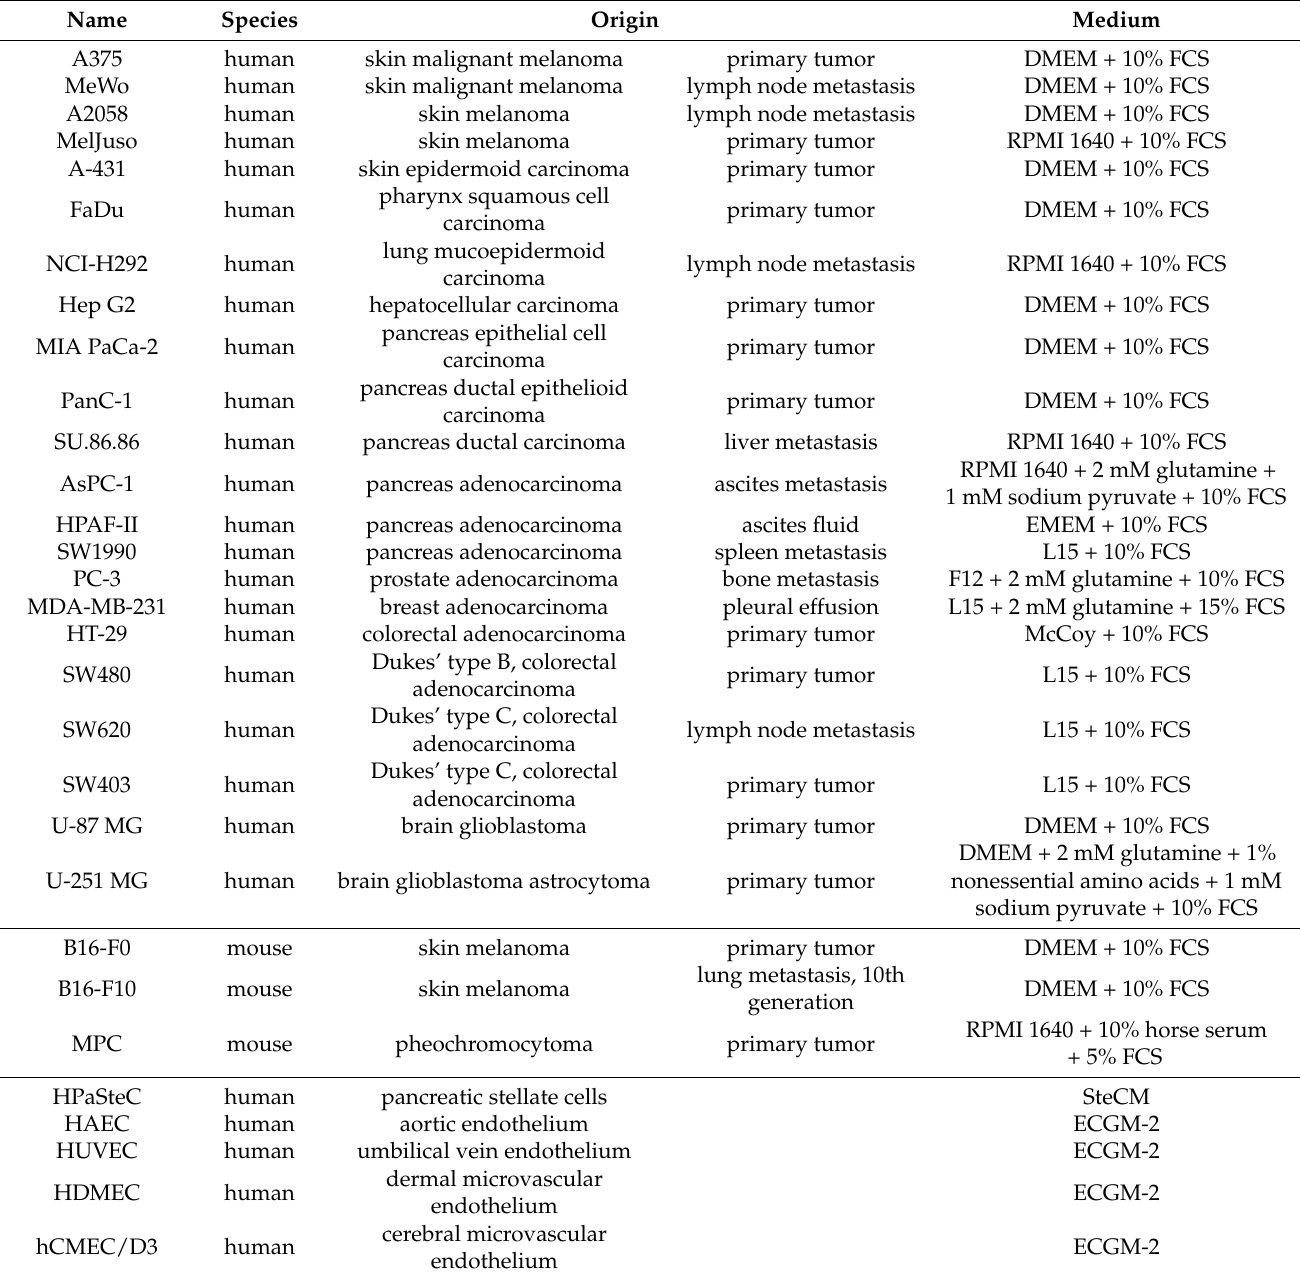
Table 5. Investigated cell lines and appropriate cell culture media (information on origin of cell lines and culture conditions have been obtained from the American Type Culture